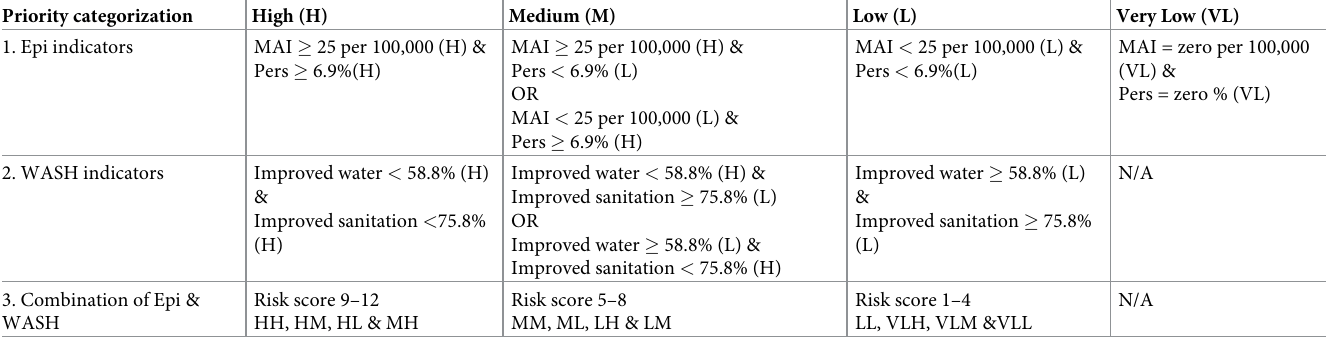
Table 1. Priority categorization by 1. Epidemiological indicators, 2. WASH indicators and 3. a combination of both Epi and WASH. Priority categorization